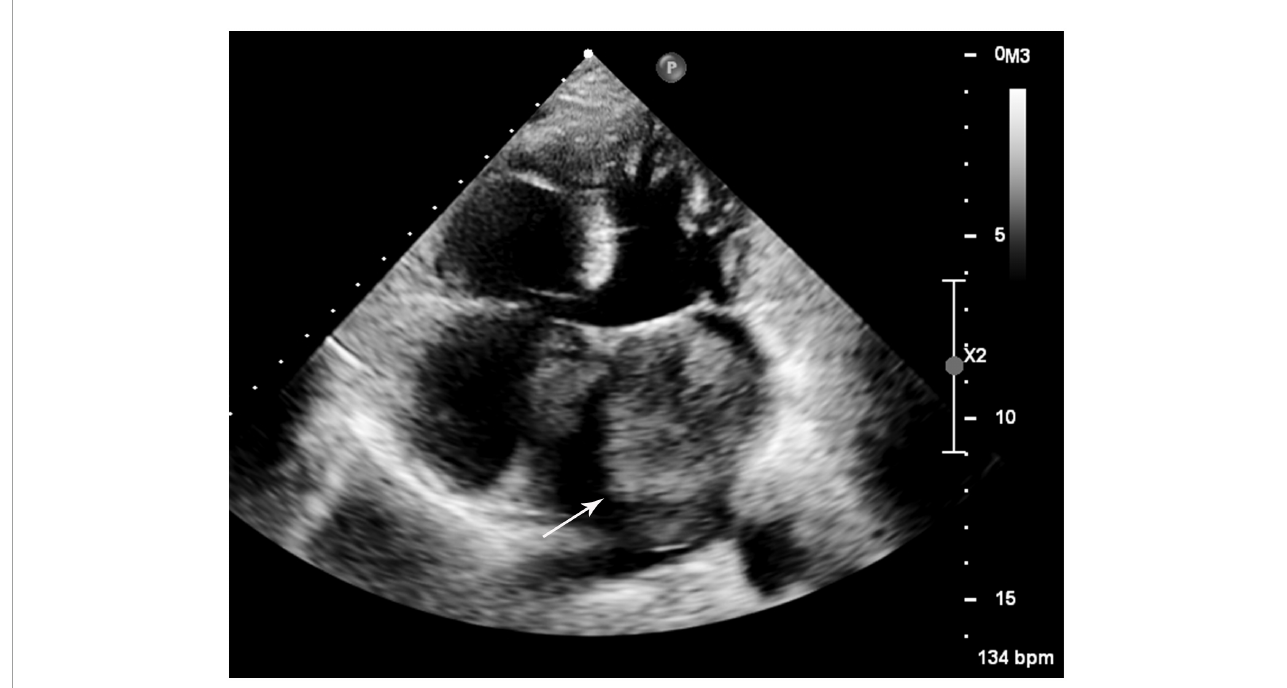
FIGURE1 Transthoracic echocardiogram of the left mass. A large hypoechoic mass (white arrow) was revealed in the left atrium attaching to the lateral atrial wall via a broad base.